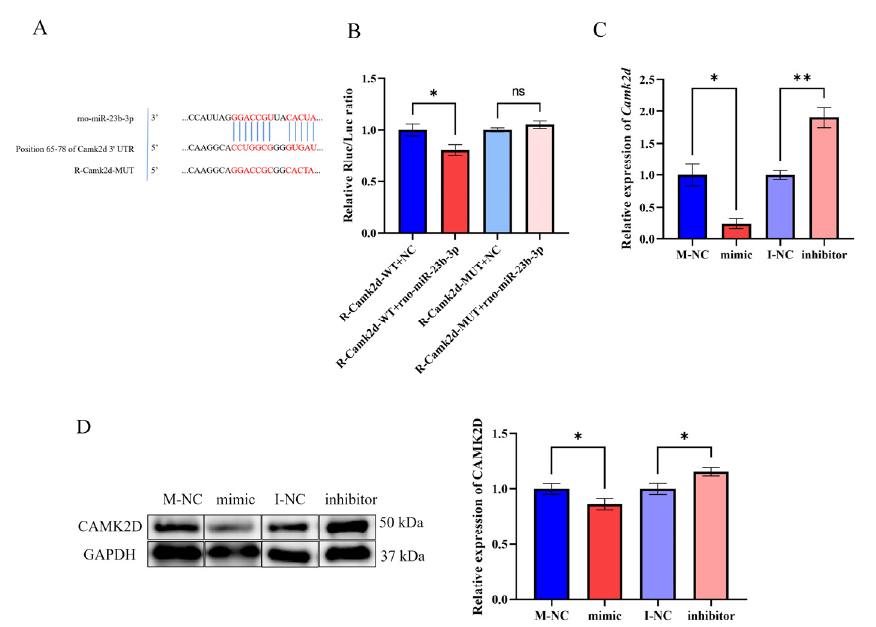
Figure 8. MiR-23b-3p targets Camk2d-3 ′ UTR and regulates its gene expression. ( A ) TargetScan’s anticipated miR-23b-3p base complementary pairing sequence with lncRNA-m23b is highlighted in red. ( B ) Changes in relative luciferase activity after the transfection of plasmids with NC/mimic. ( C , D ) Camk2d mRNA and CAMK2D protein changes after miR-23b-3p mimic/inhibitor transfection. ns, p > 0.05; *, p < 0.05; **, p < 0.01.